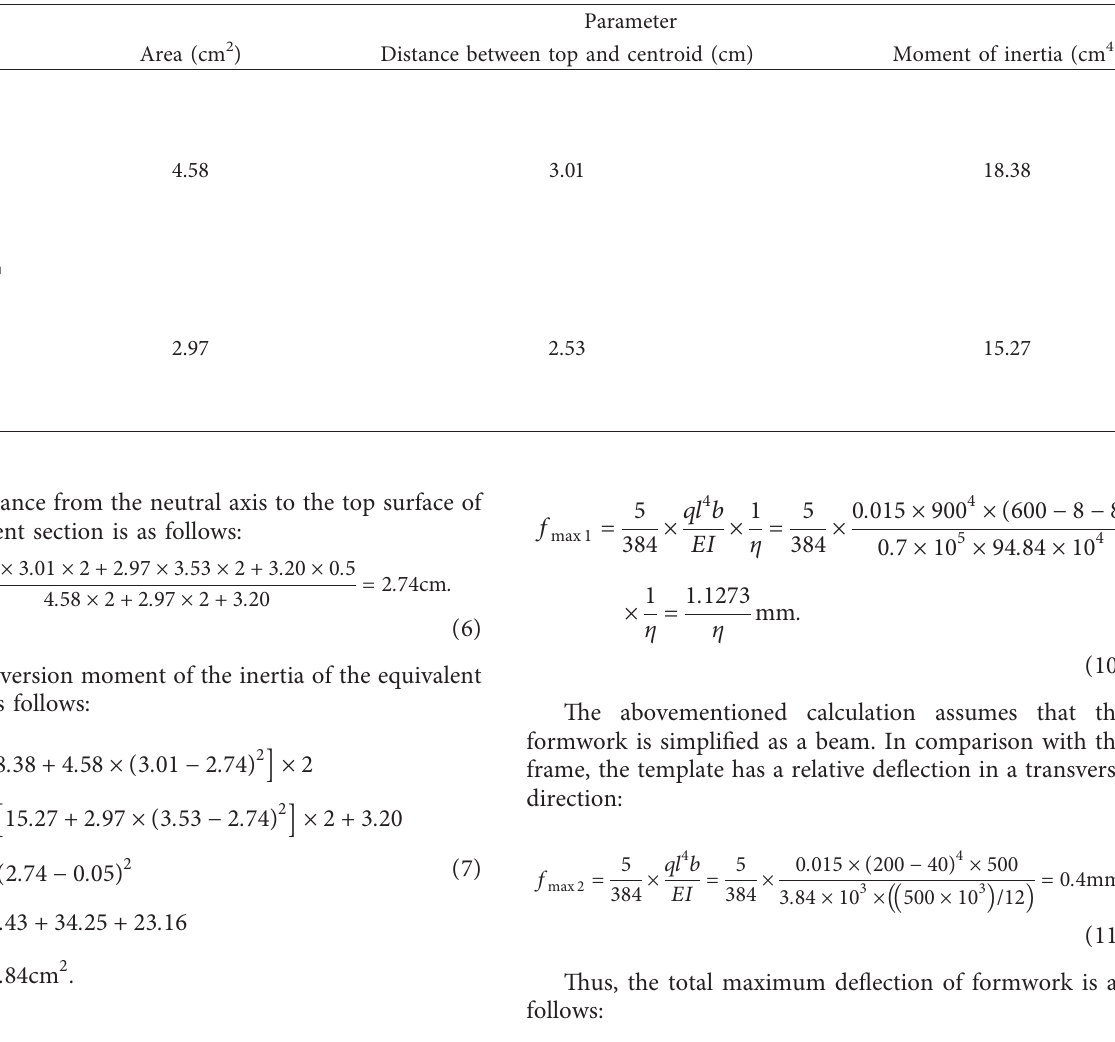
Table 7: Cross-sectional geometry of the longitudinal beams of the